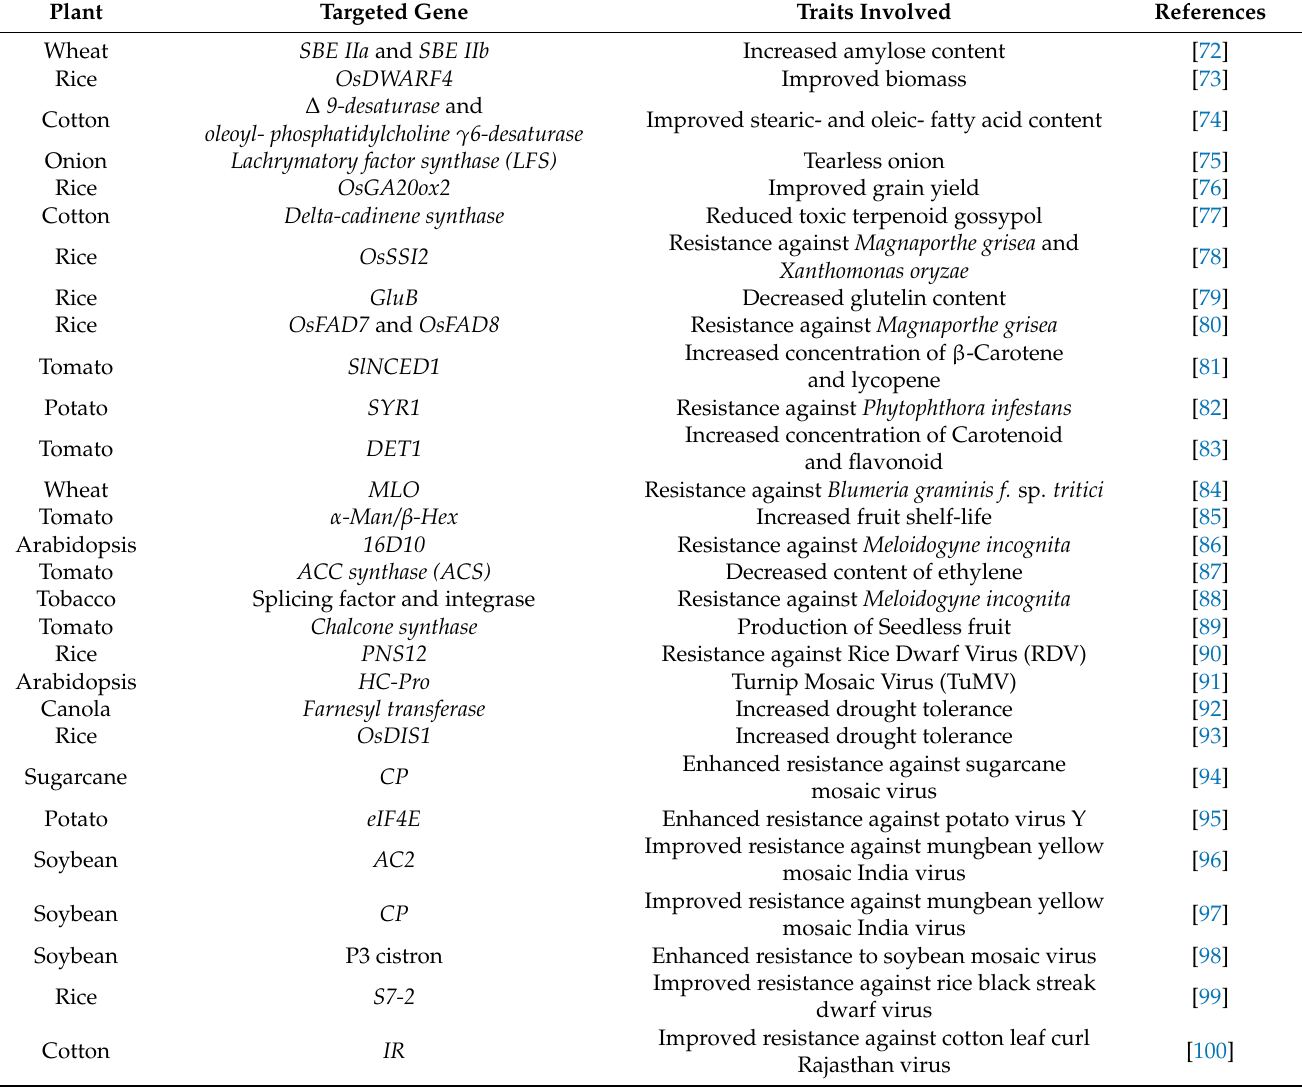
Table 2. Genetic alteration of siRNAs in plants to improve the desirable